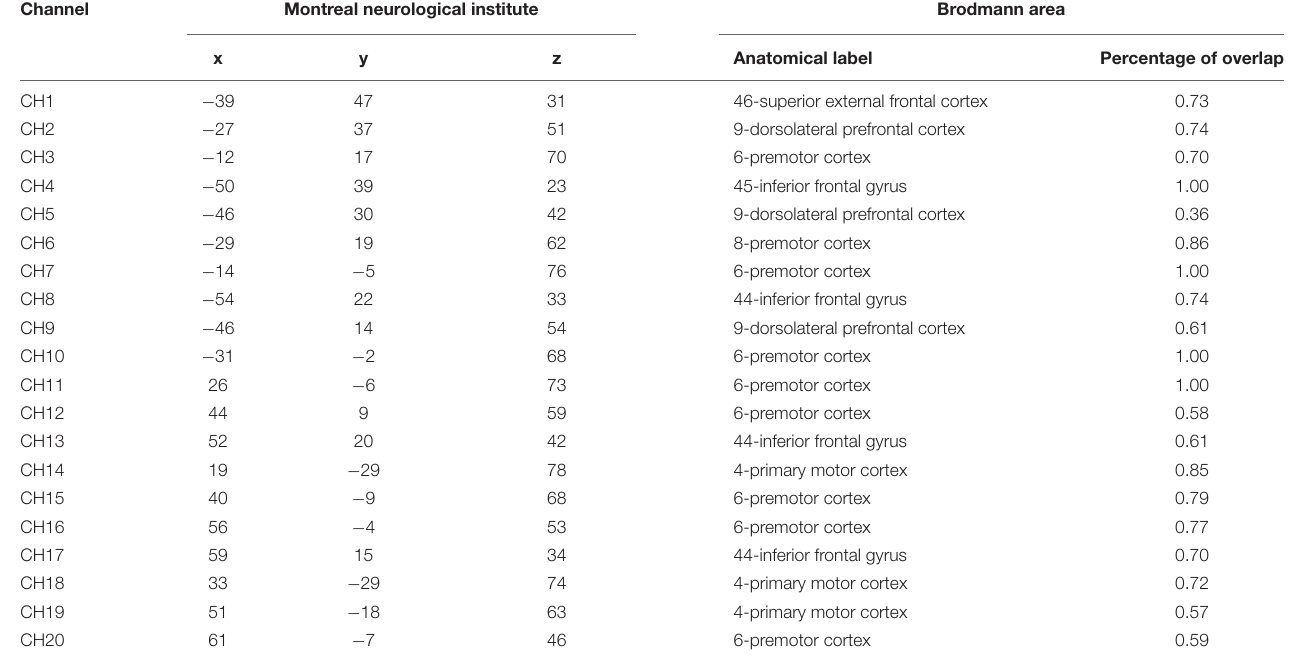
TABLE 1 | Position of all fNIRS channels. Channel Montreal neurological